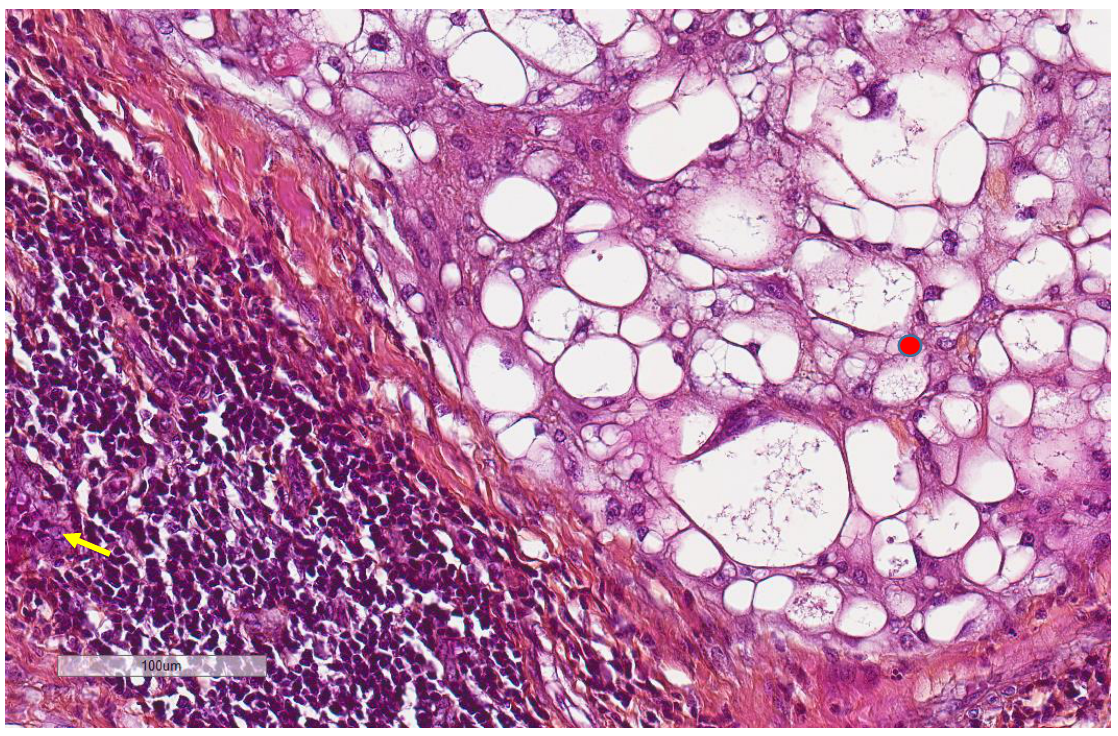
Figure 14. Representative image (×200 magnification) of the morphological aspect of high endothelial venules (arrow). Nearby, the tumor (red circle) cells are shown.